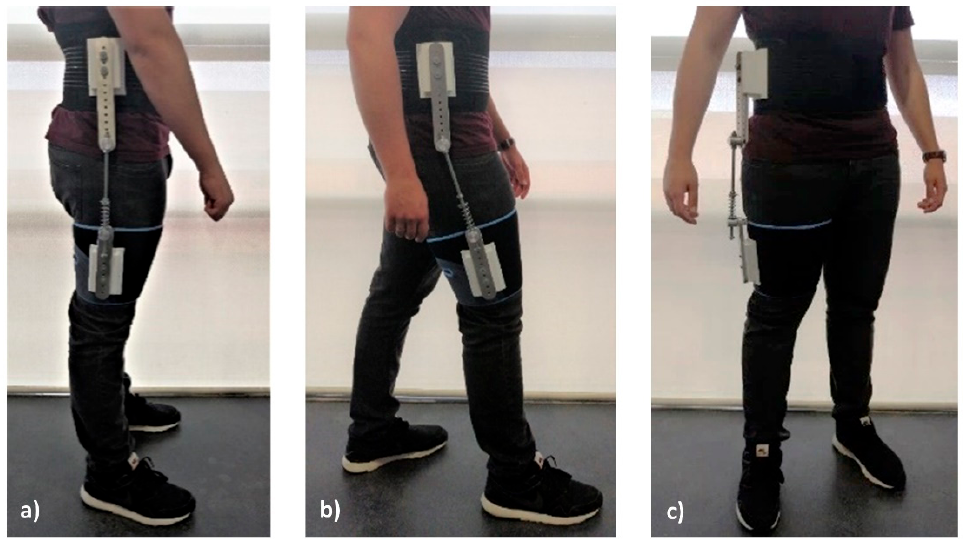
Figure 5. Physical prototype: ( a ) side view in an upright position; ( b ) lateral view in flexion; ( c ) oblique view.